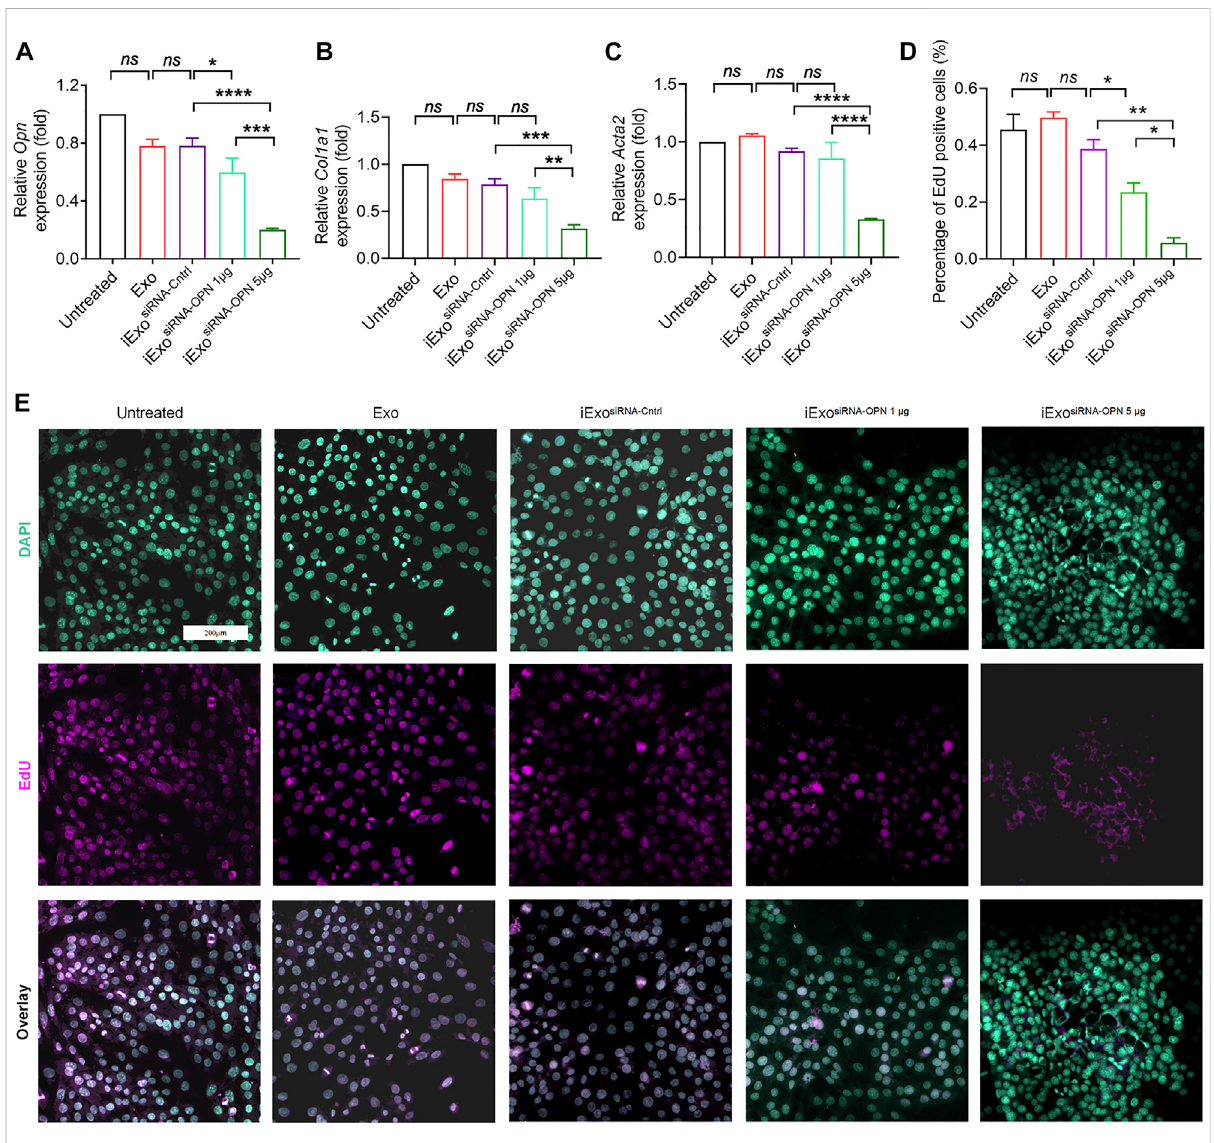
FIGURE 4 iExosomestargetingOPNinhibitliver fi brosis invitro . (A) Opn expressionbyqPCRanalysisinprimaryHSCstreatedwithiExosomeselectroporatedwith 1 μ g or 5 μ g siRNA-OPN. n = 3 independent experiments. (B) Col1a1 expression by qPCR analysis in primary HSCs subjected to listed treatment. n = 3 independent experiments. (C) Acta2 expression in primary HSCs with the indicated treatment by qPCR analysis. n = 3 independent experiments. (D,E) ProliferatecellsstainedwithEdU (E) andthepercentageofpositivecells (D) tototalcellsinprimaryHSCsineachgroup. n =3.Thedatain fi gure (A – C) arepresentedasOne-wayANOVAwithSidak ’ spost – hocanalysis;Brown-ForsytheandWelchANOVAwithDunnett ’ sT3post-hocanalysiswereusedin fi g (D) . p < 0.05 *, p < 0.01**, p < 0.001 ***, p < 0.0001